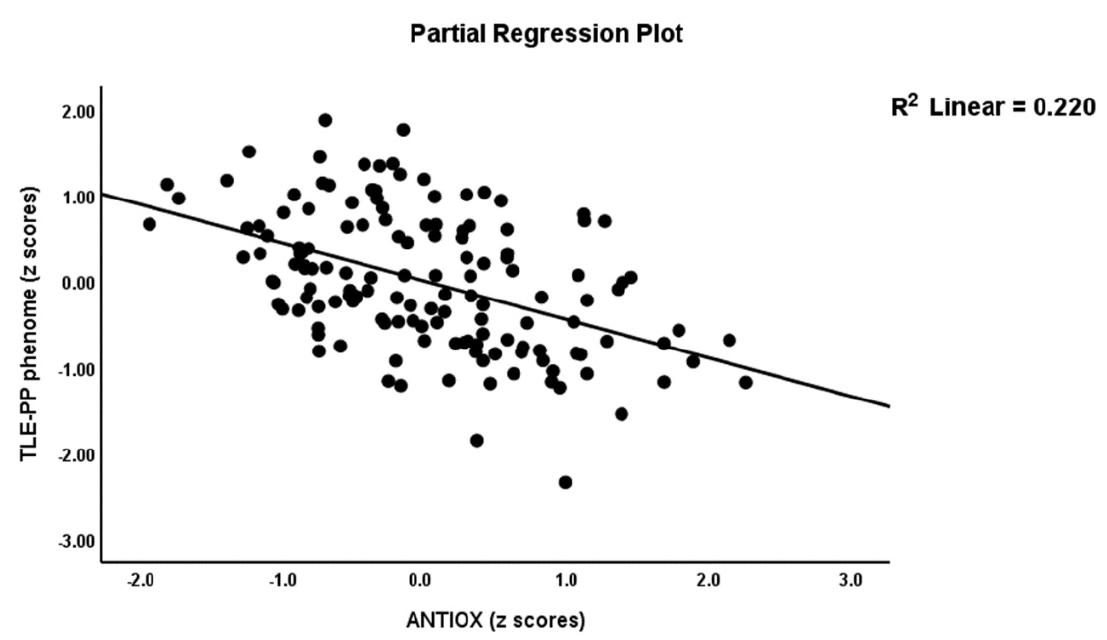
Figure 2. Partial regression of temporal lobe epilepsy—psychopathology phenome score on the index of antioxidant defenses (ANTIOX). Table 2, model #3 shows that 31.8% of the variance in the frequency of seizures was explained by MDA (positively), NOx, ANTIOX and age (all inversely). Table 2, model #4 shows that 23.8% in the uncontrollability of seizures was explained by ANTIOX and NOx (both inversely) and MDA